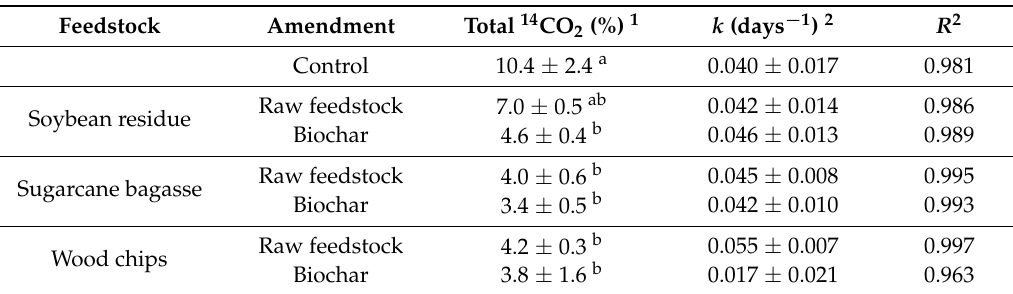
Table 4. Total 14 CO 2 released throughout the 30 days incubation period expressed as a % of the initial 14 C-alachlor added to soils and first order kinetics of 14 CO 2 evolution throughout the incubation period (fit using mean values for each time